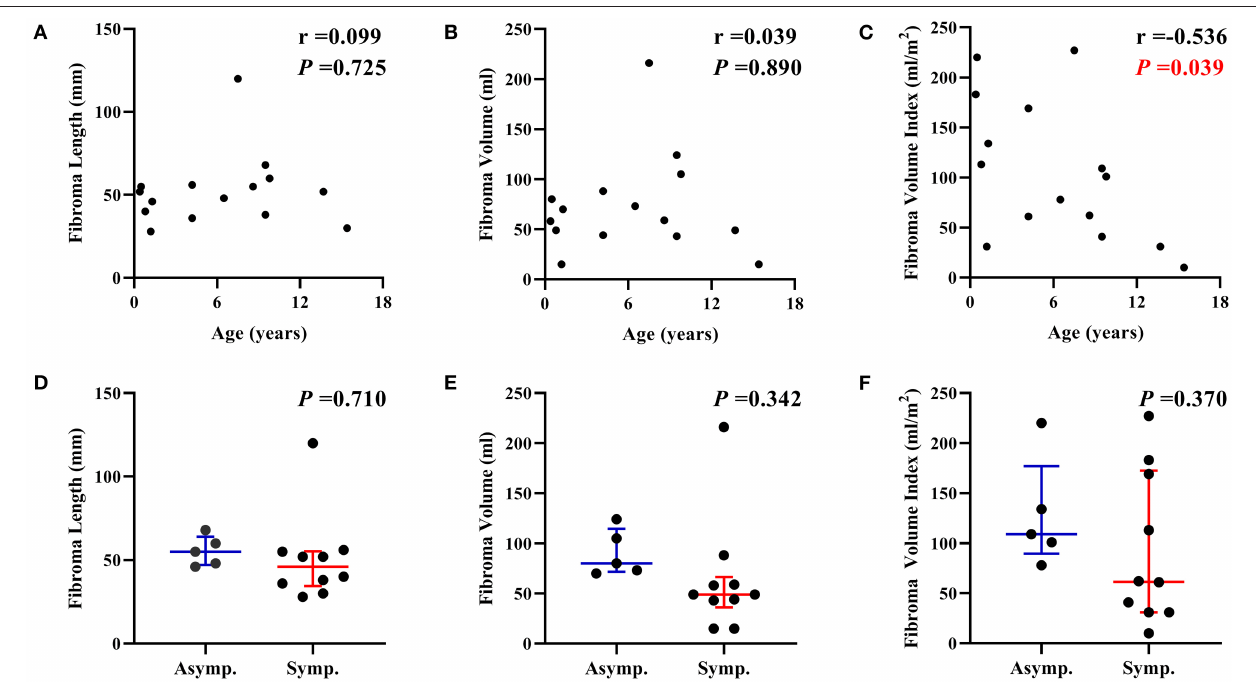
FIGURE 3 | Correlation between cardiac fibroma size with age and clinical presentation. (A) The length and (B) the volume of cardiac fibromas were not correlated with age. (C) The fibroma volume index was negatively correlated with age. There was no significant difference between symptomatic patients ( n = 10) and asymptomatic patients ( n = 5) in (D) the length, (E) the volume, and (F) the volume index of fibromas. Asymp., asymptomatic; Symp., symptomatic.